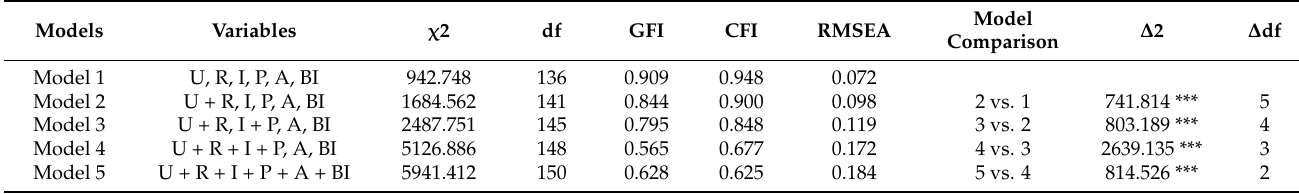
Table 3. Model Comparison.